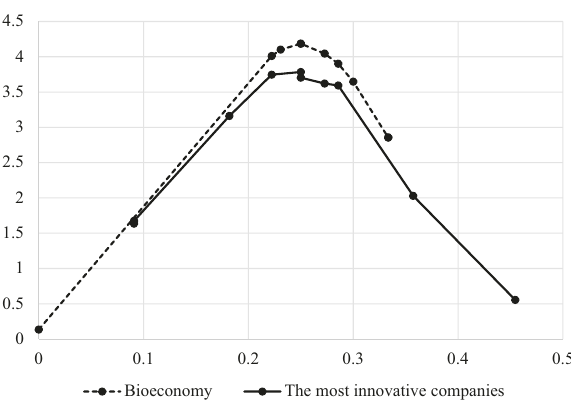
Fig. 4 Normal distribution of the gender diversity in the bioeconomy and the most innovative companies. Gender diversity in bioeconomy (dotted line) versus the most innovative companies (solid line). The data depicts greater age spread for the most innovative companies.